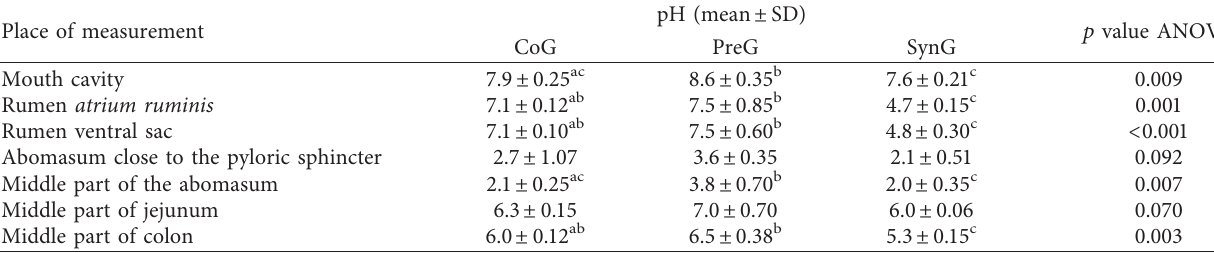
Figure 1: Full experimental Table 1: The pH in different parts of the gastrointestinal canal.